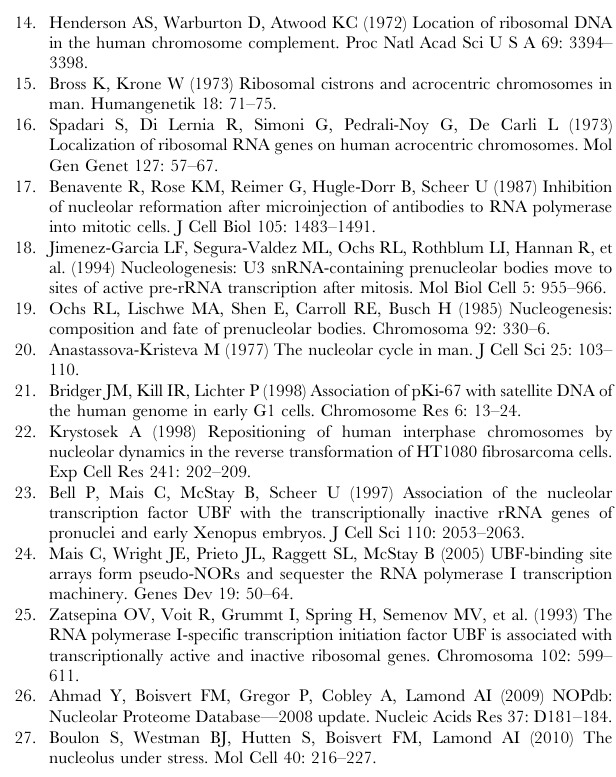
was measured on individual nucleoli and plotted in box plots. Statistically significant differences ( p , 0.05) were calculated using a Student t -test. (TIF) Figure S5 DNA damage in whole nuclei accumulates at nucleoli in the presence of dnTRF2. Immunostaining and FISH on three-dimensionally preserved nuclei from control and dnTRF2-expressing cells showed an increase in the association of gamma H2AX (red) at nucleoli after 48 hour dnTRF expression. Fibrillarin (green) was used to identify nucleoli. Pearson Coefficient of Correlation was used to quantitate the amount of co-localization between fibrillarin and gamma H2AX. The average coefficient was higher (0.38) for dnTRF2-expressing cells compared to controls (0.23), suggesting more association of DNA damage at nucleoli. (TIF) Figure S6 Condensin localization at isolated nucleoli decreases with dnTRF2 expression. (A) The condensin subunit SMC4 (green) localizes in a punctate pattern at isolated nucleoli marked by immunostaining with fibrillarin (FIB). (B) SMC4 (green) shows some co-localization with TRF2 (red). Scale bars in all panels throughout the figure are 5 micrometers. (C) Extent of SMC4 (green) and TRF2 (red) co-localization in control cells indicated with a plot showing the Pearson coefficient of correlation. Higher coefficients (approaching 1) denote a greater degree of overlap with SMC4 (AFU = arbitrary fluorescence unit). (D) Decreased co-localization of TRF2 with SMC4 after 30 hours of dnTRF2 expression is indicated by a lower coefficient. (E) Pearson coefficient of correlation (SMC4 x TRF2) was measured for multiple control nucleoli (grey) and dnTRF2 30-hour nucleoli (black). The scatterplot shows a significant decrease in overlap with dnTRF2 expression. (TIF)